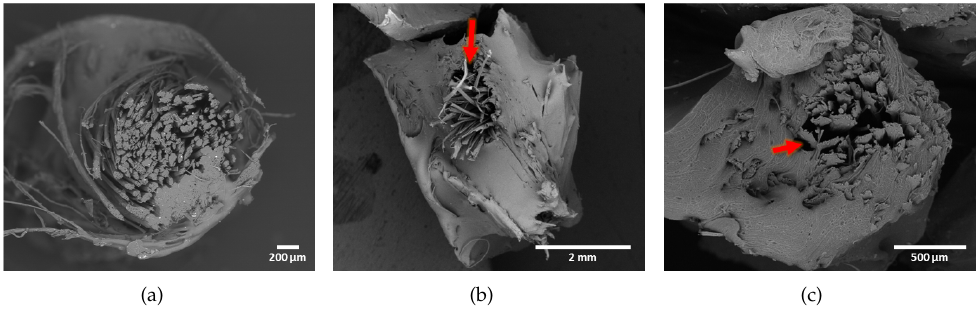
Figure 7. SEM cross-section images of ( a ) in natura, ( b ) XSBR-coated, and ( c ) PCM-impregnated and XSBR-coated jute yarns.